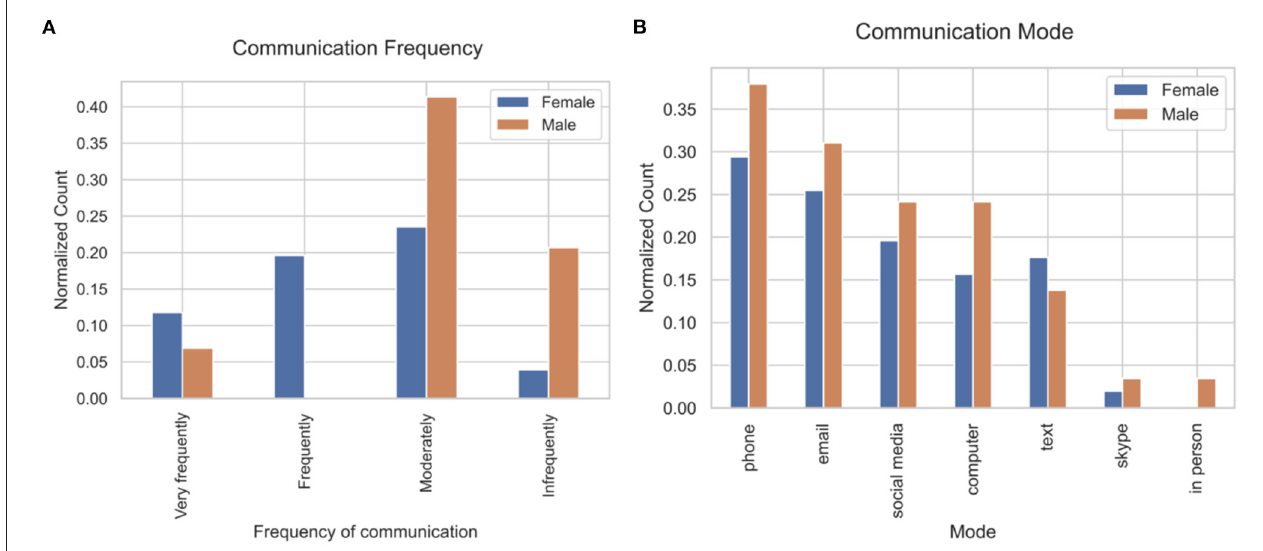
TABLE 2 | Binary-classification performance with loneliness (Leave one out) * $ .